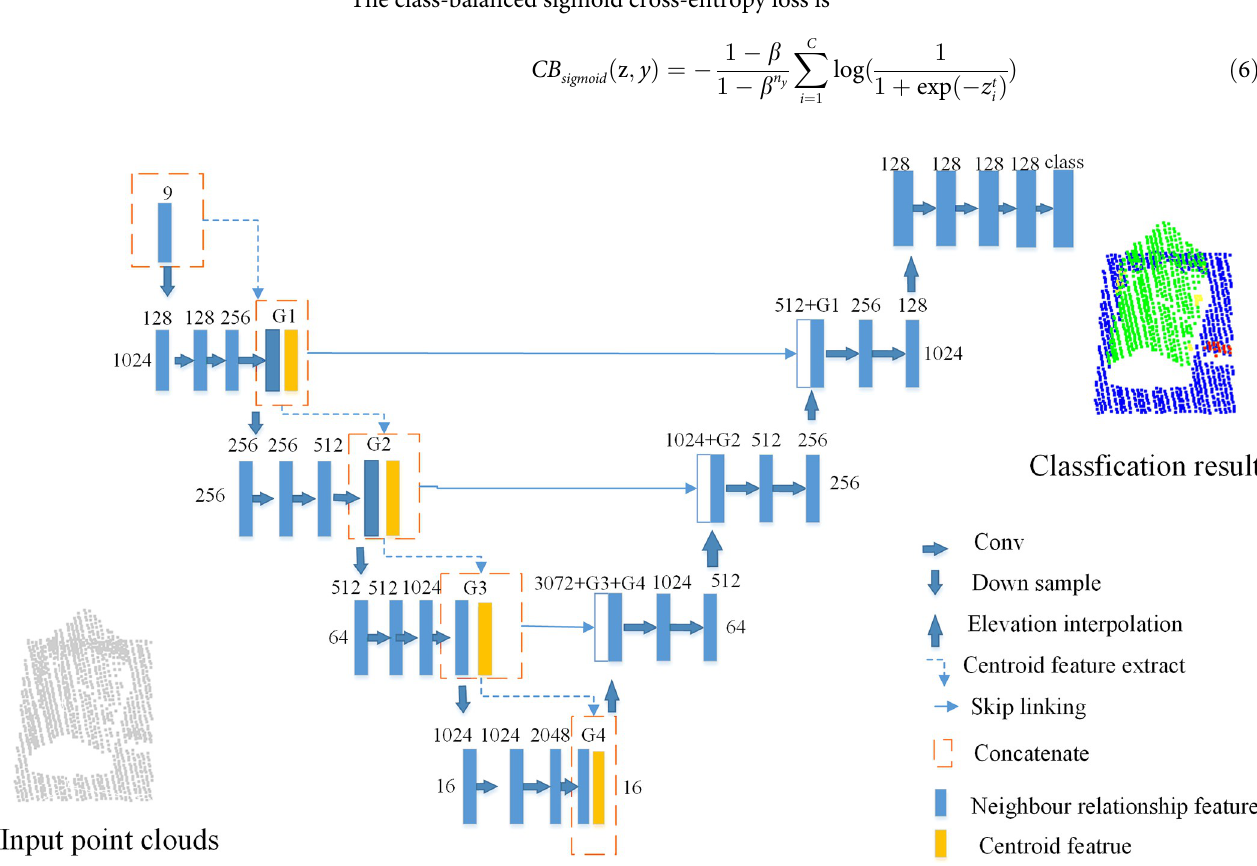
Fig 1. Overview of our proposed network architecture. This architecture added features on centroid and neighbour relationship. The input point clouds on the left are input points, and the output is the classification result.